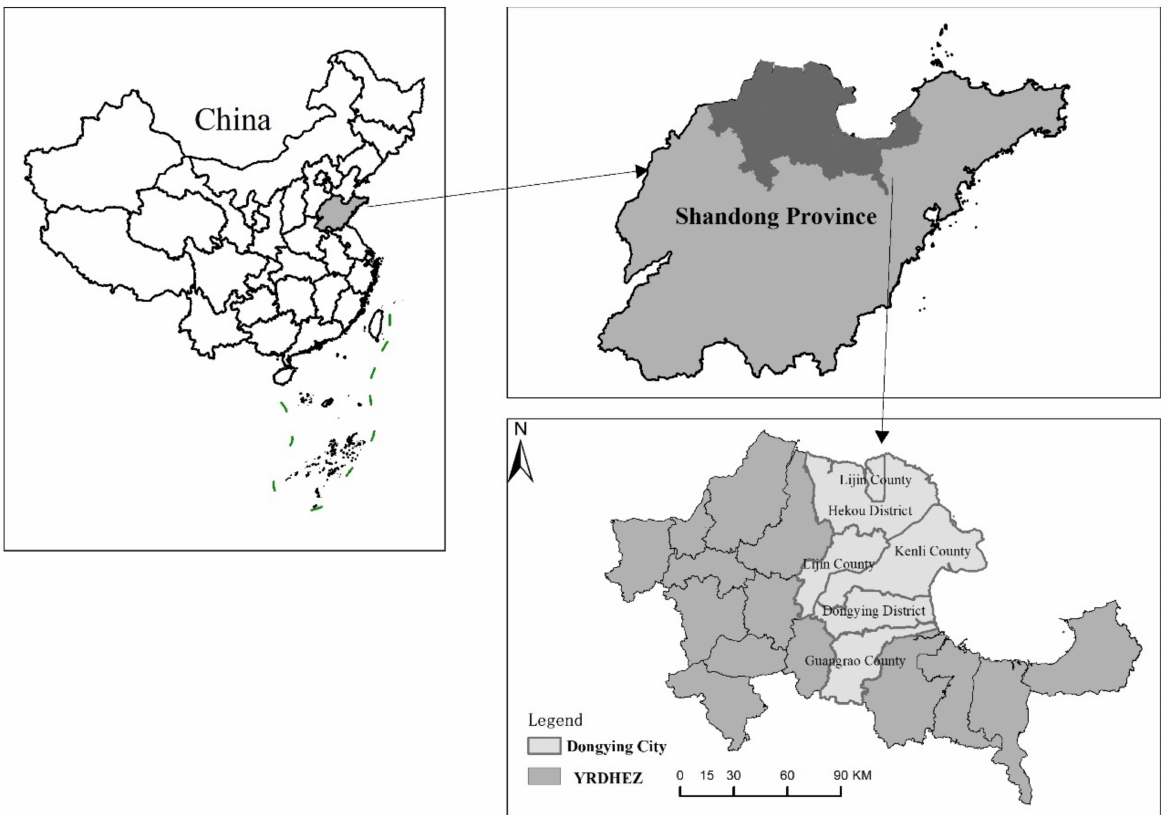
Figure 1. The location of the study ar2.2. Data